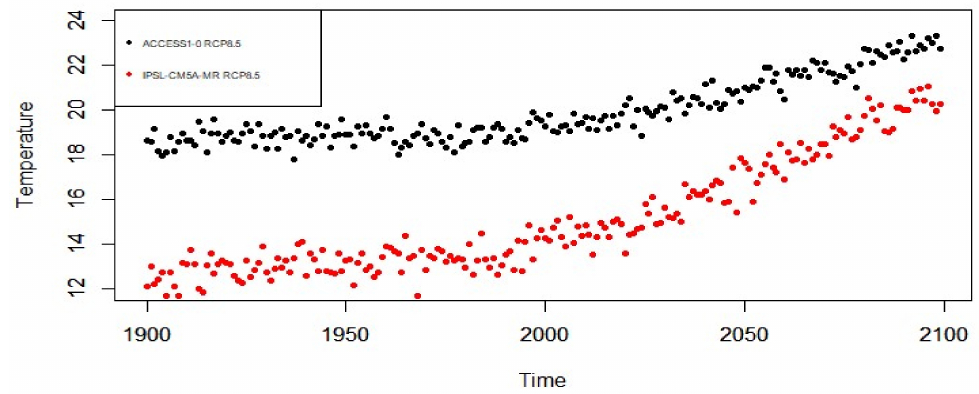
Figure 30. RCP 8.5 hot model (ACCESS1-0) and warm model (IPSL-CM5A-MR), temperature in ◦